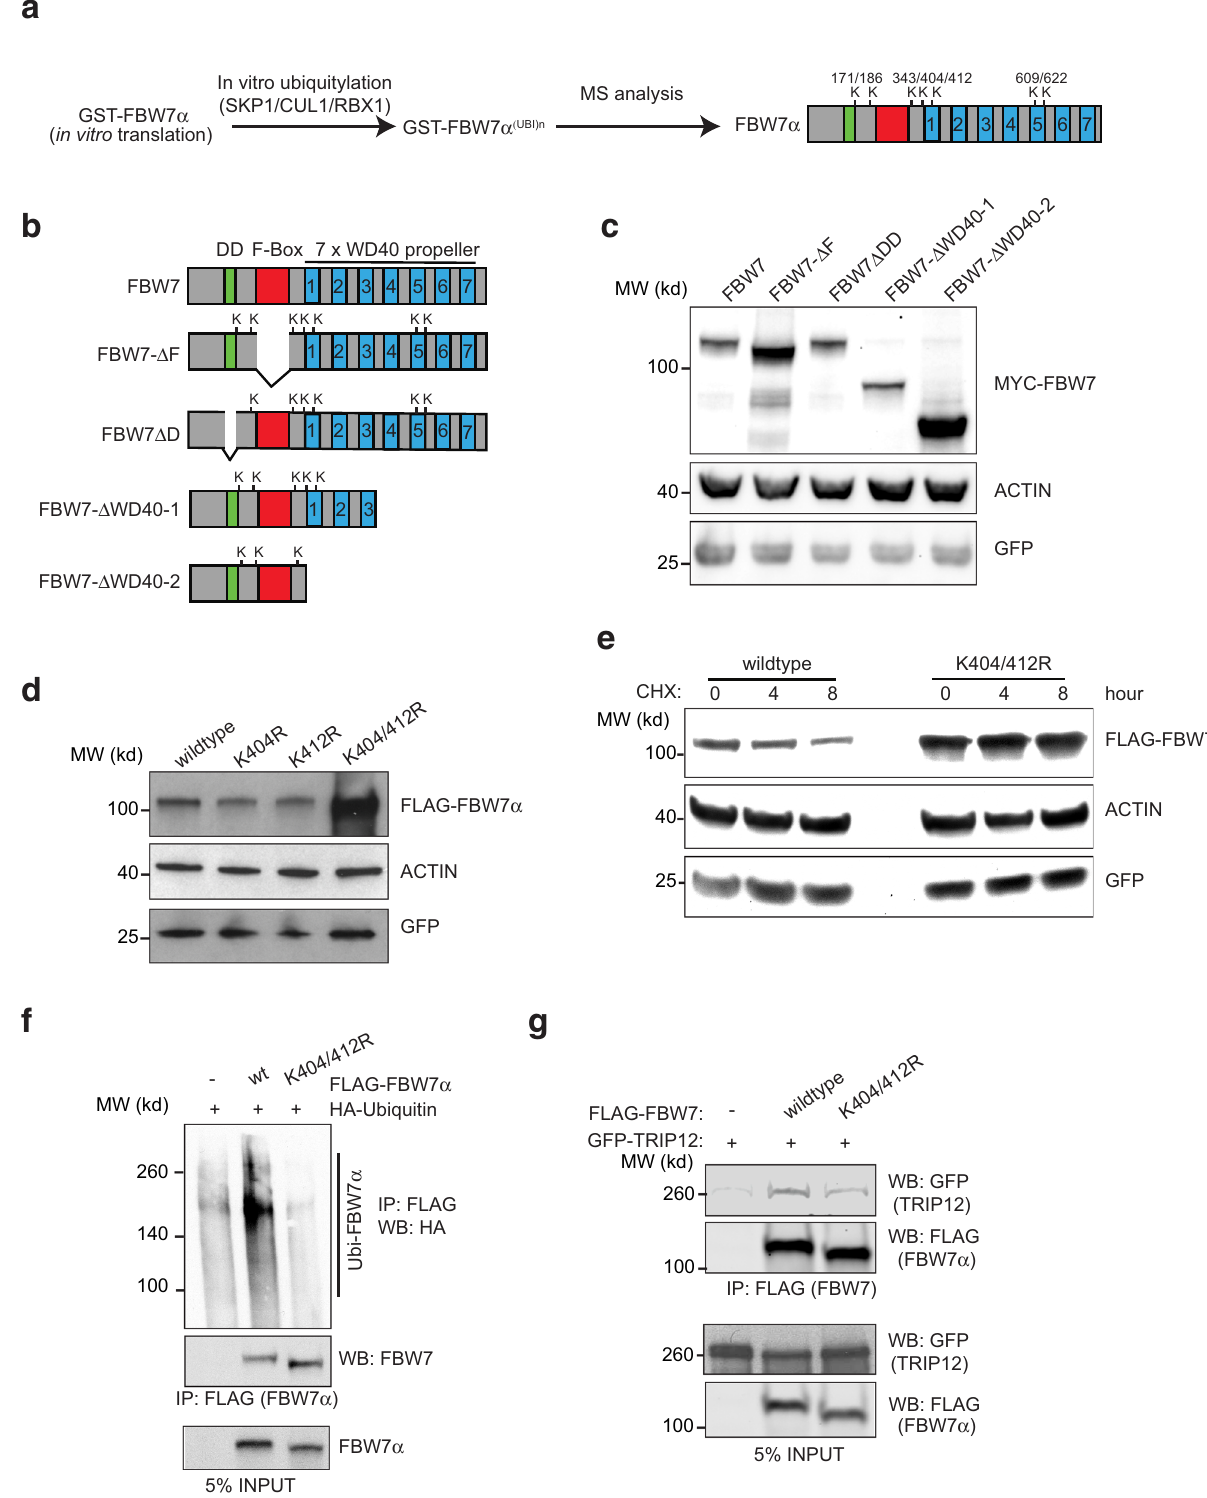
chains on FBW7 (Fig. 7b). In vitro FBW7 autoubiquitylation did not involve K11-linked polyubiquitin conjugates (Fig. 7c, lane 2), as previously suggested by the Ubi-Crest assay (Fig. 6e, f). Strikingly, addition of TRIP12 together with UBE2S